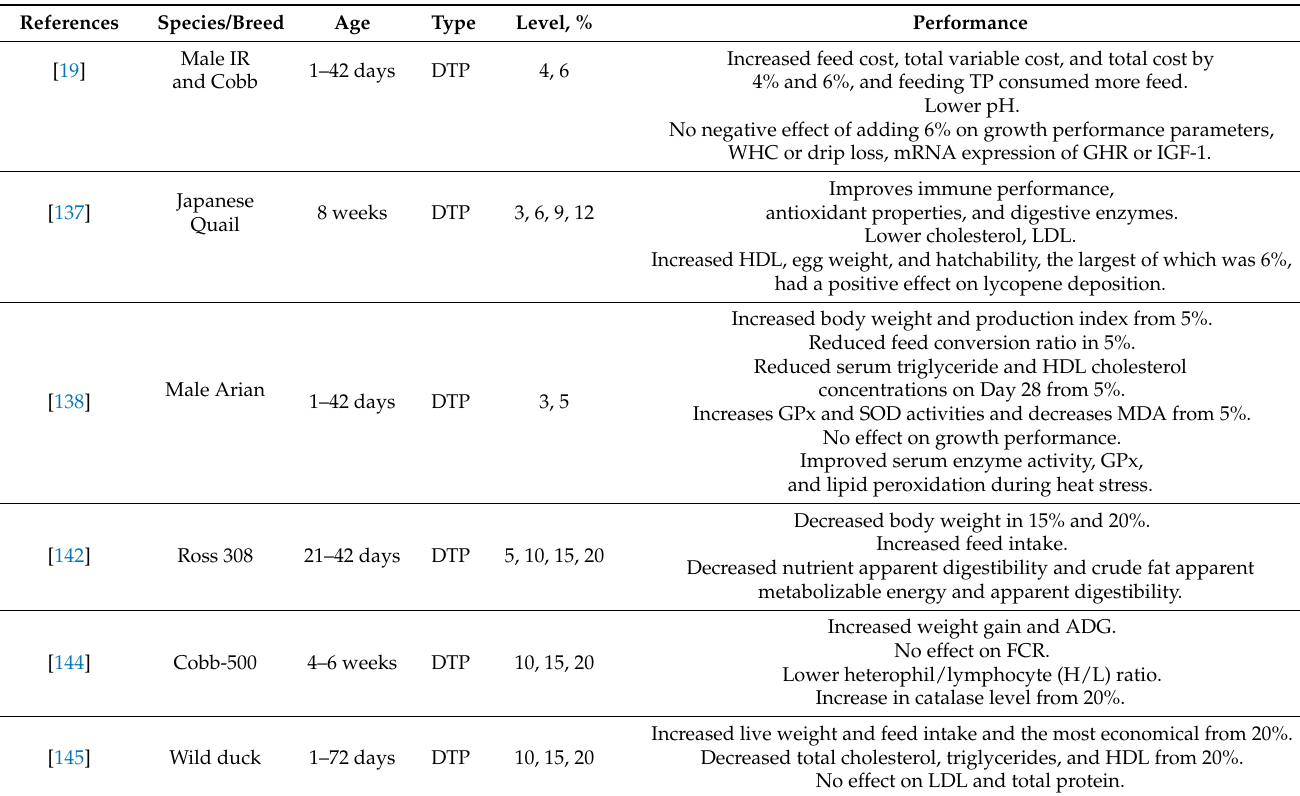
Table 6. The effect of tomato pomace on